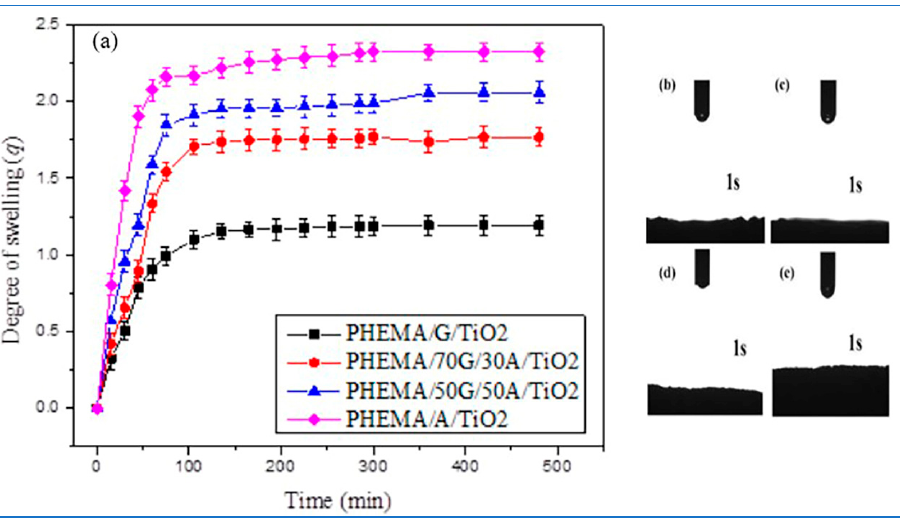
Figure 4. ( a ) Swelling profiles for PHEMA/G/TiO 2, PHEMA/70G/30A/TiO 2 , PHEMA/50G/50A/TiO 2, PHEMA/A/TiO 2 ; Water contact angle measurements in 1 s of ( b ) PHEMA/G/TiO 2 , ( c ) PHEMA/70G/30A/TiO 2 , ( d ) PHEMA/50G/50A/TiO 2 , ( e ) PHEMA/A/TiO 2 hybrid scaffolds.